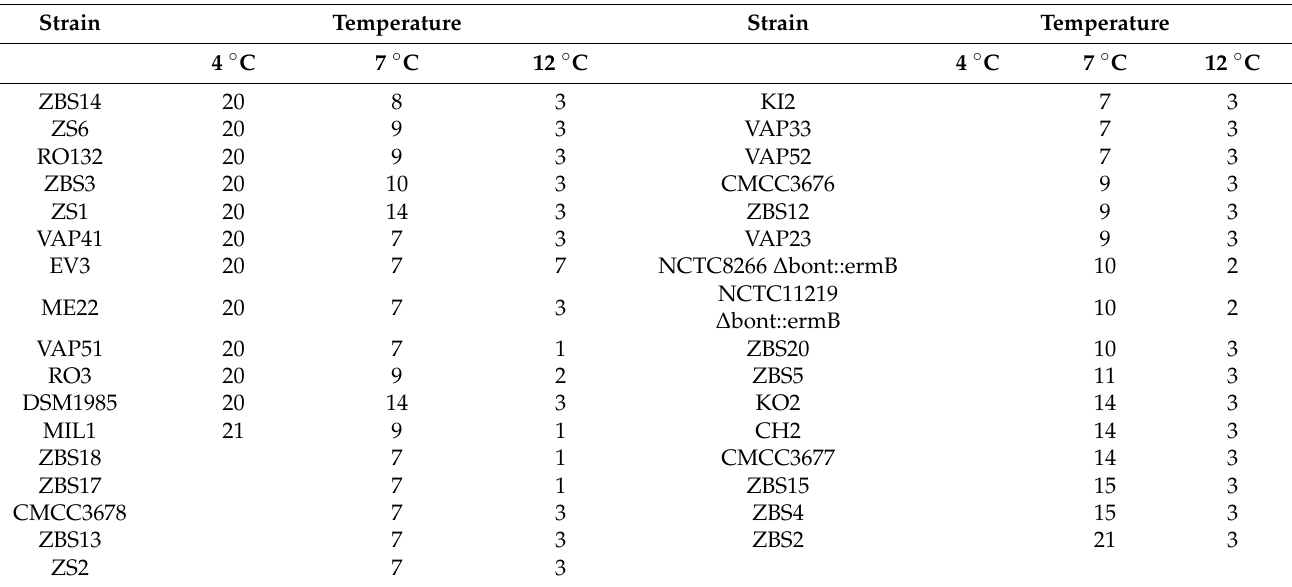
Table 7. Growth of nontoxic isolates, NCTC8266 ∆ bont::ermB and NCTC11219 ∆ bont::ermB on RCM agar at 4 ◦ C, 7 ◦ C and 12 ◦ C, monitored for 21 days for three replicates per